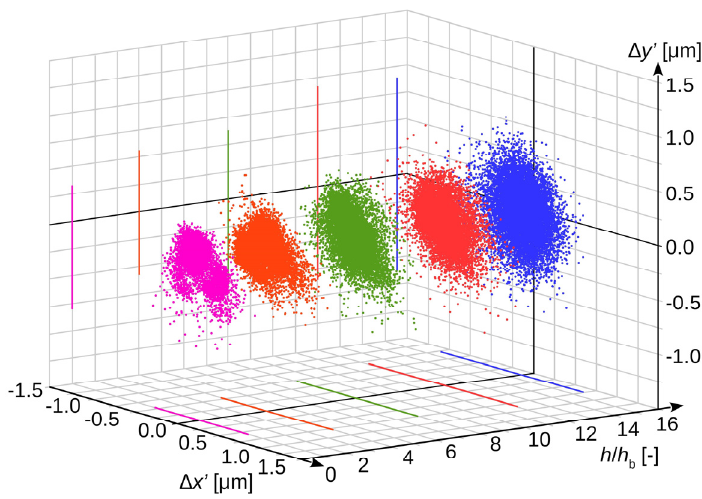
Figure 5. Stochastic distribution of the obtained results as a function of sensor sensitivity level.